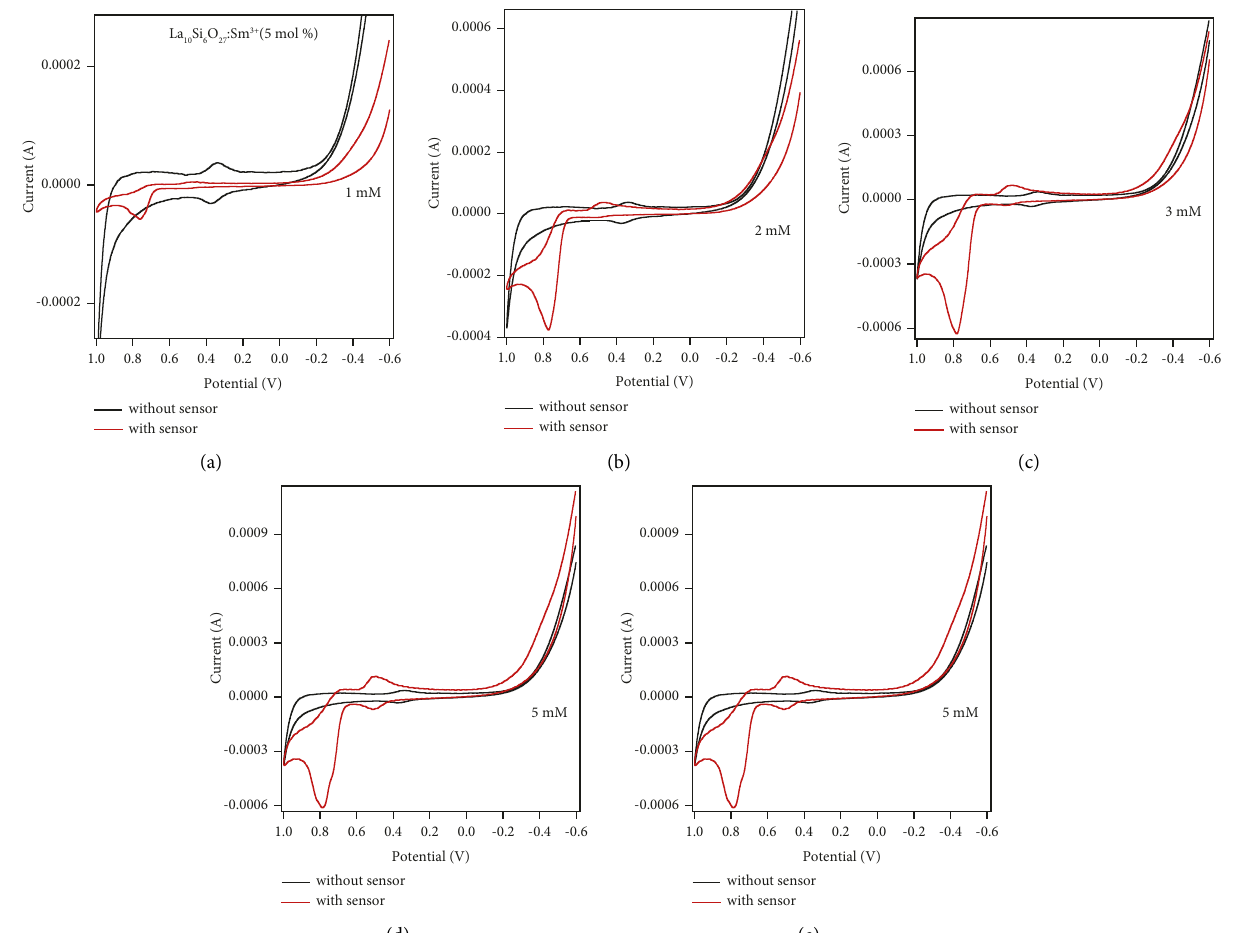
Figure 10: Cyclic voltammogram of La range